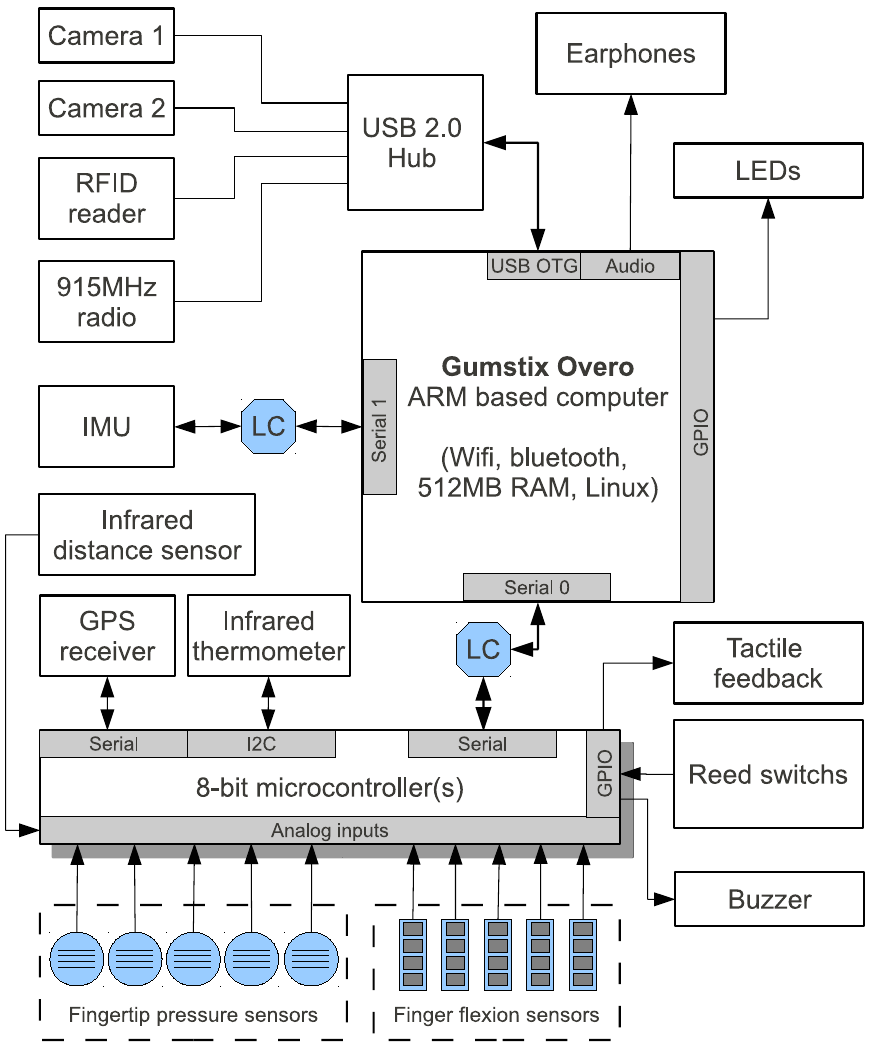
Figure 2. Wearable mobile sensing platform hardware block